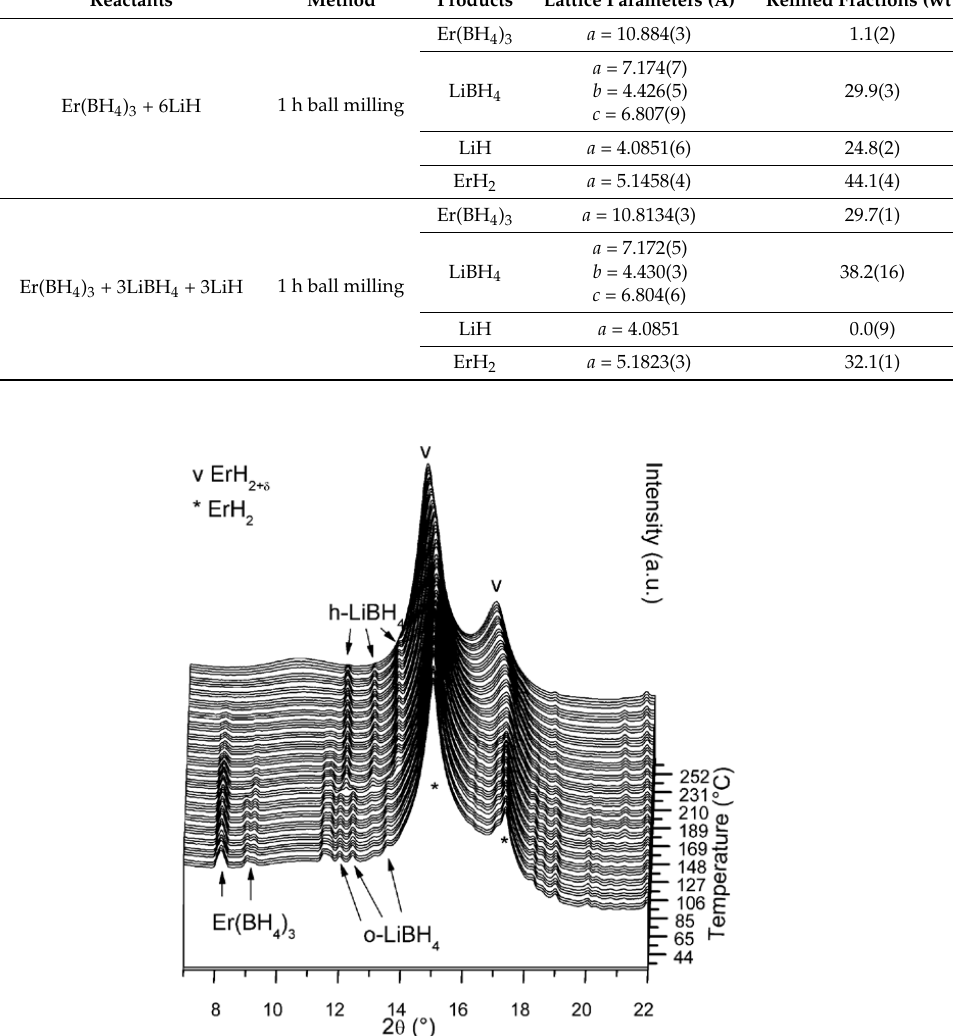
Table 1. Compositions and synthesis method of the investigated samples. The products after ball milling are given with lattice parameters and fractions from Rietveld refinements of diffraction data at room temperature (RT). Refinements are shown in Table S1. Sample S2 was stored in a glove box for nine months before measurements were taken. Estimated standard deviations are given in parentheses.